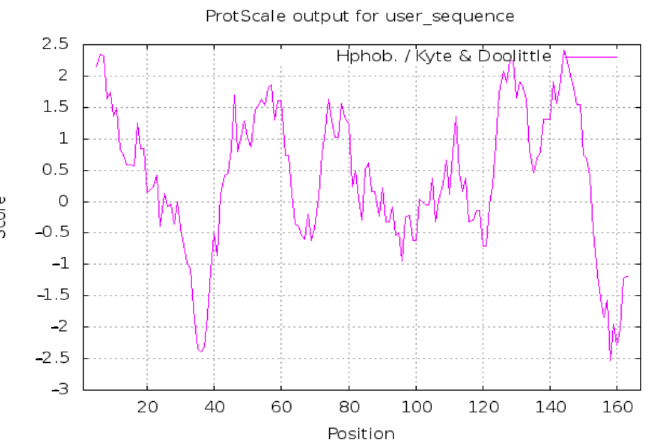
Figure 1. Hydrophobicity and hydrophilicity of soybean GmPLMT predicted by ProtScale.